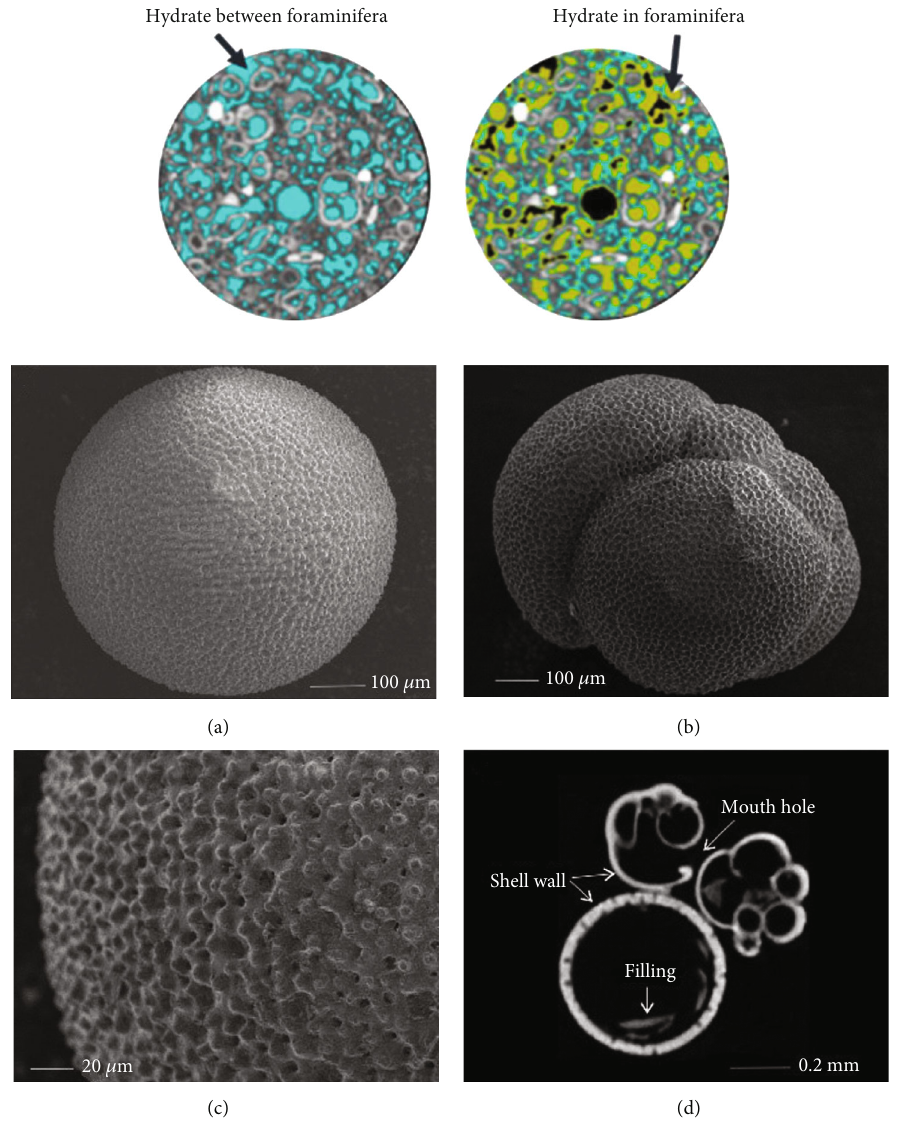
Figure 6: Characteristics of a hydrate reservoir rich in foraminifera and surface and internal images of the foraminifera shells (Li et al.,